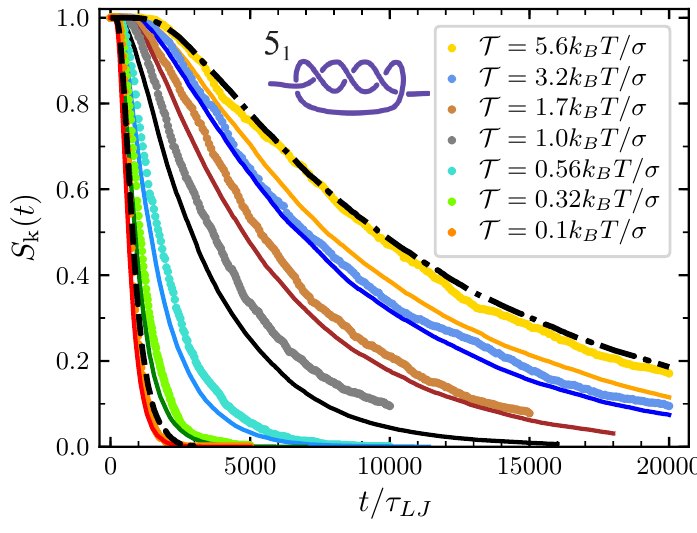
Figure 7. Same as Figure 6 but in the case of the 5 1